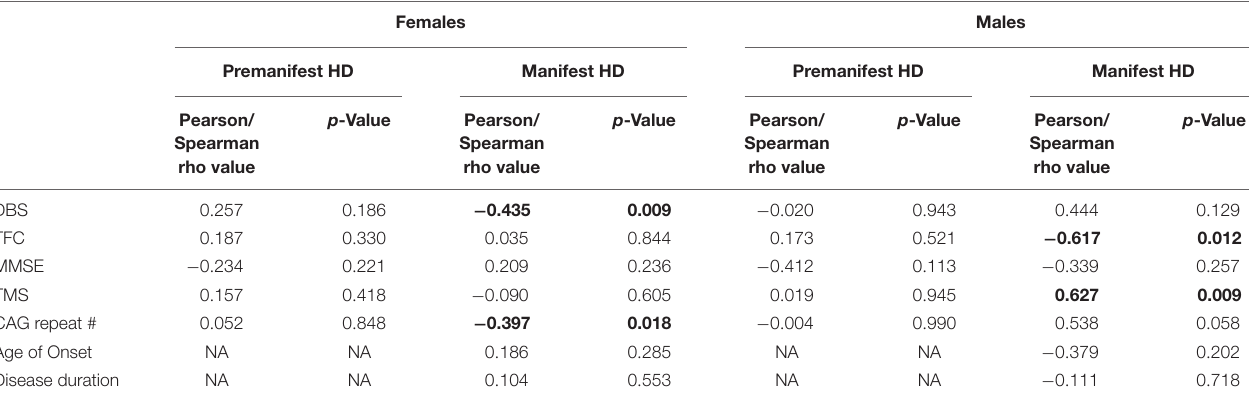
TABLE 3 | Correlations between salivary uric acid and clinical and disease data in female and male HD patients. Females